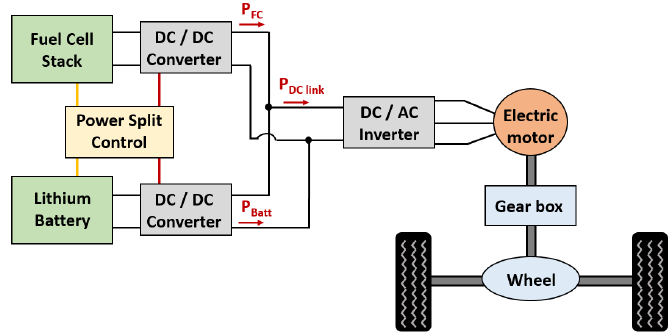
Figure 3. System structure of the fuel cell hybrid electric vehicle.